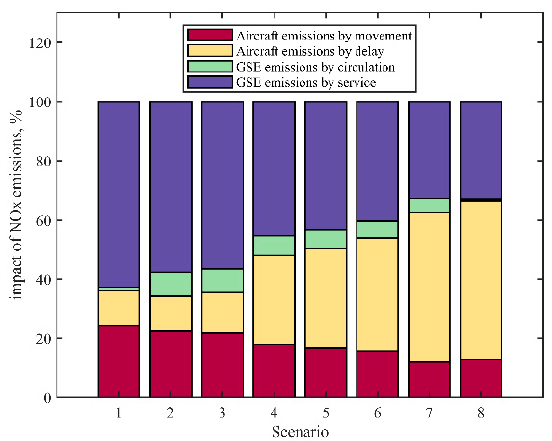
Aerospace 2021 , 8 , 87 Figure 10. NOx impact per group and process. Figure 10. NOx impact per group and process. Figure 10. NOx impact per group and process.